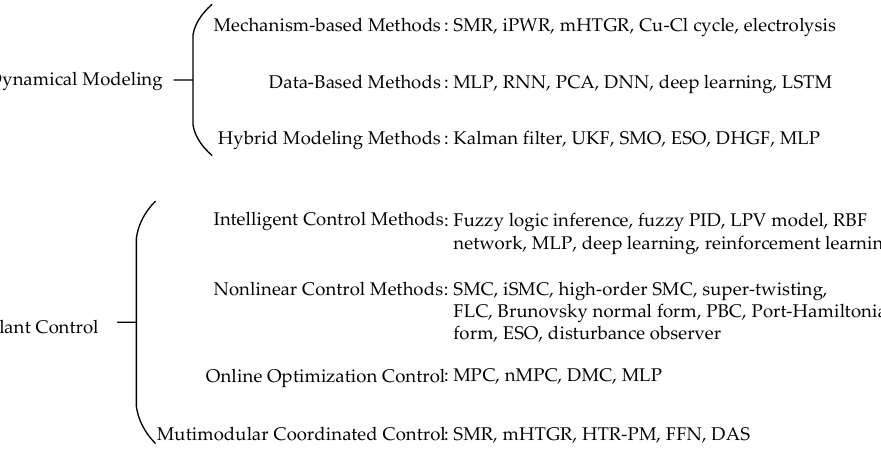
Figure 4. Mind map of technical review in Sections 2 and